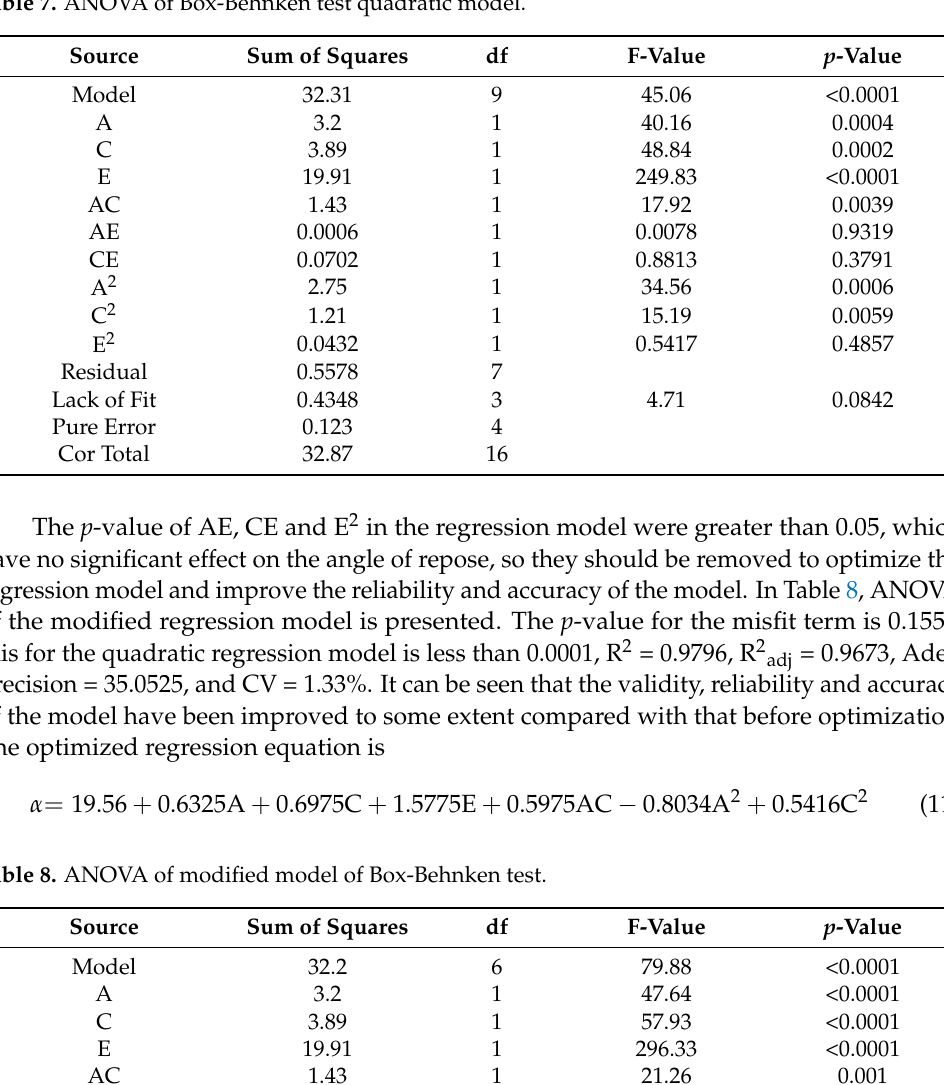
Table 7. ANOVA of Box-Behnken test quadratic model.